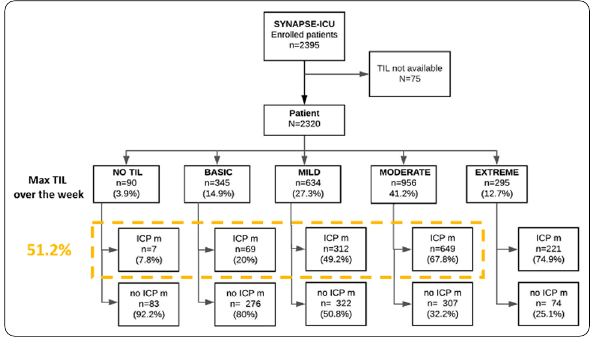
therapy = ICP monitored =